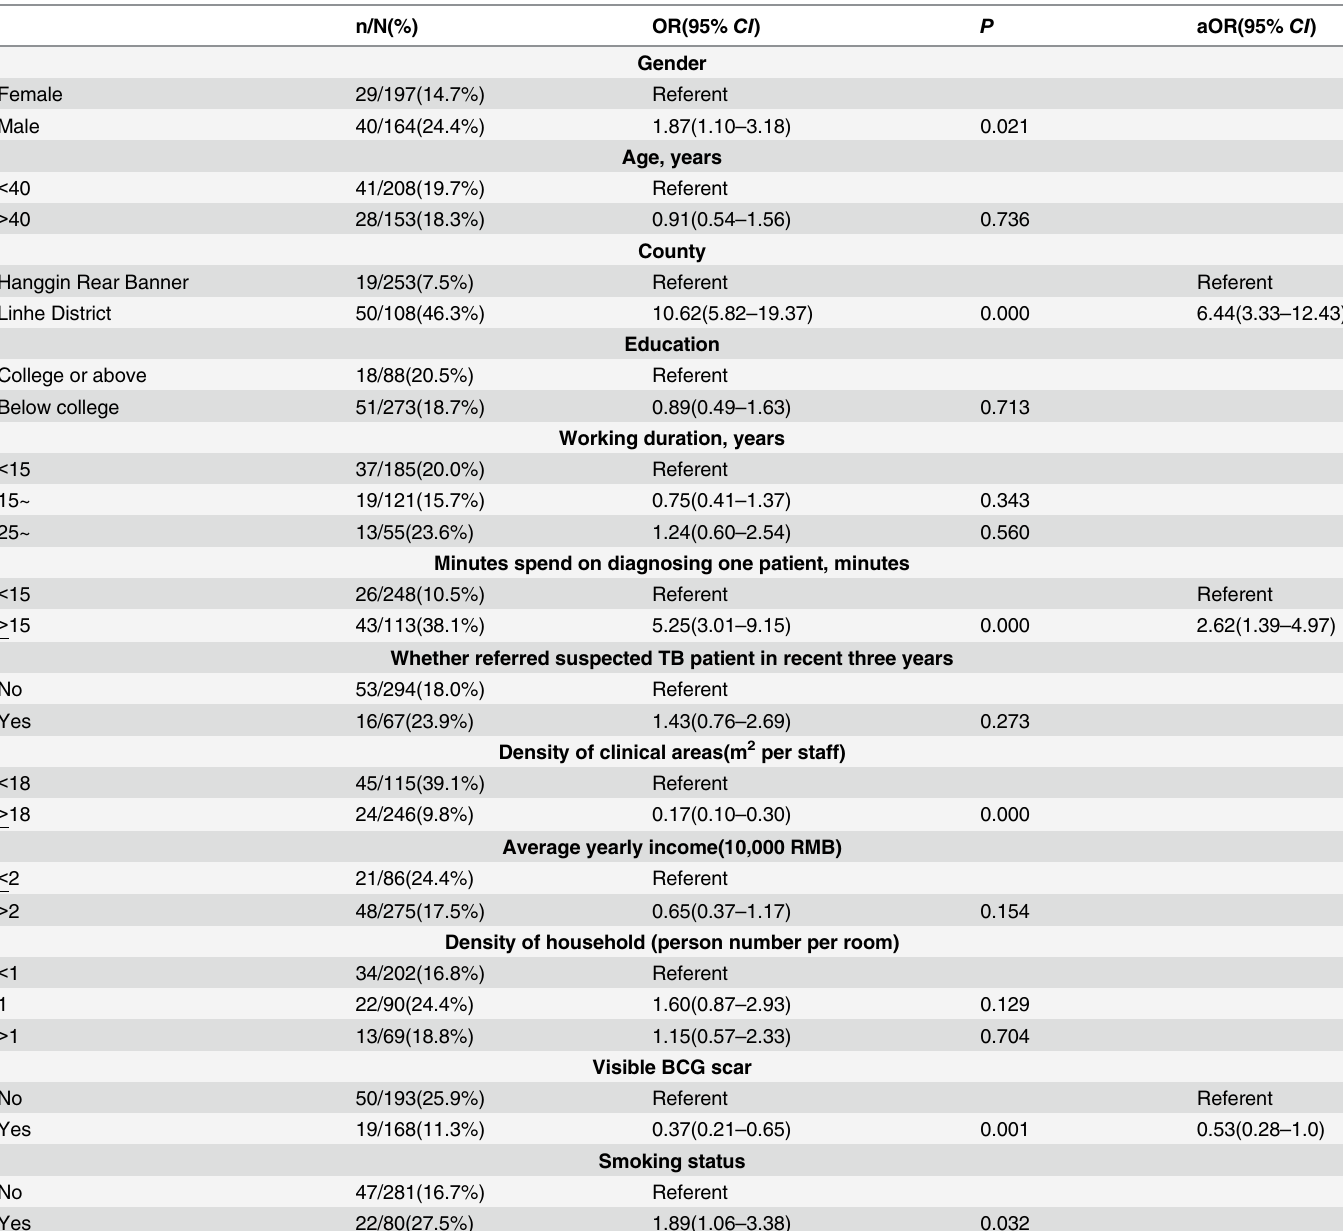
Table 6. Factors associated with LTBI conversion detected by QFT-GIT (n = 361) *